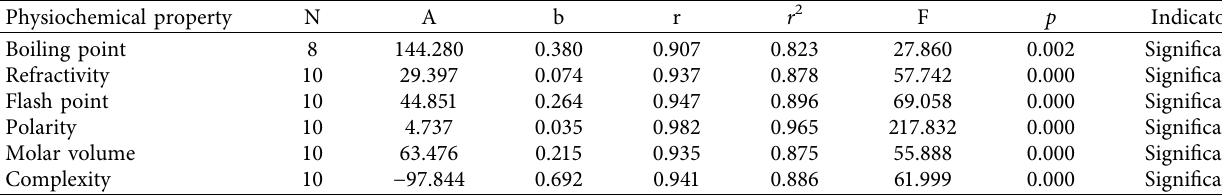
Table 10: Statistical parameters used in the QSPR model of F(G).